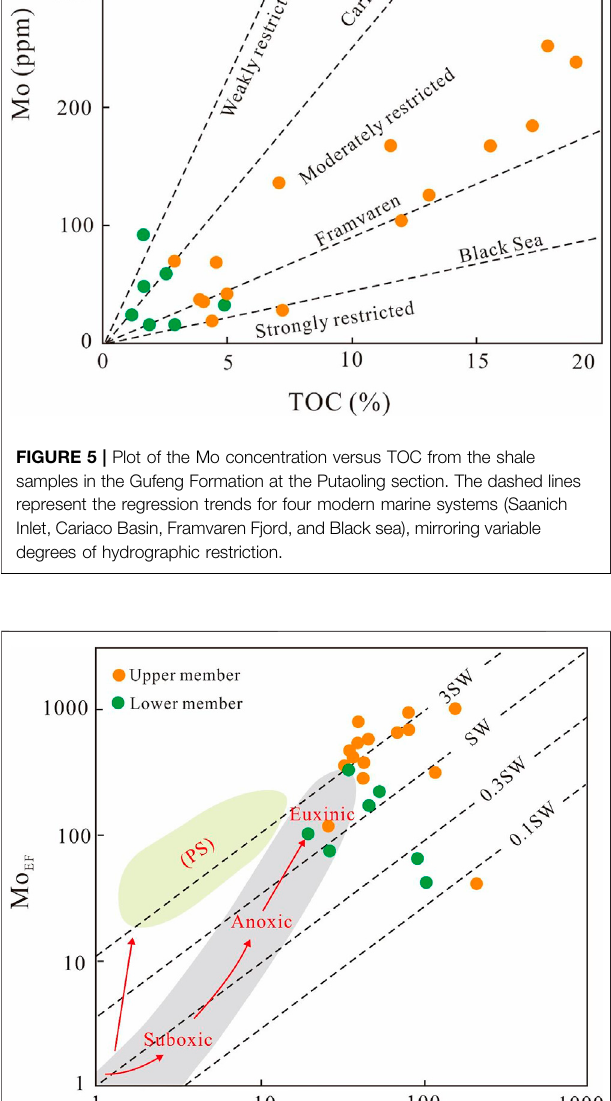
Frontiers in Earth Science |